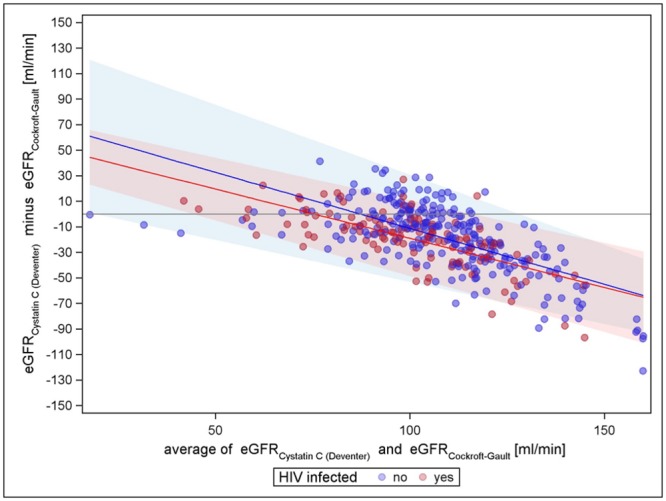
Cystatin C (van Deventer) vs. Cockcroft-Gault.The coloured lines represent the mean differences of the two equations to be compared at every point of the mean of the estimated GFRs, by HIV status; the coloured shaded areas mark the limits of agreement, which are mean- differences plus or minus two standard-deviations. Assuming a normal distribution, 95% of the dots are expected to appear within the limits of agreement. [40] Closer margins reflect a higher agreement of the different methods.